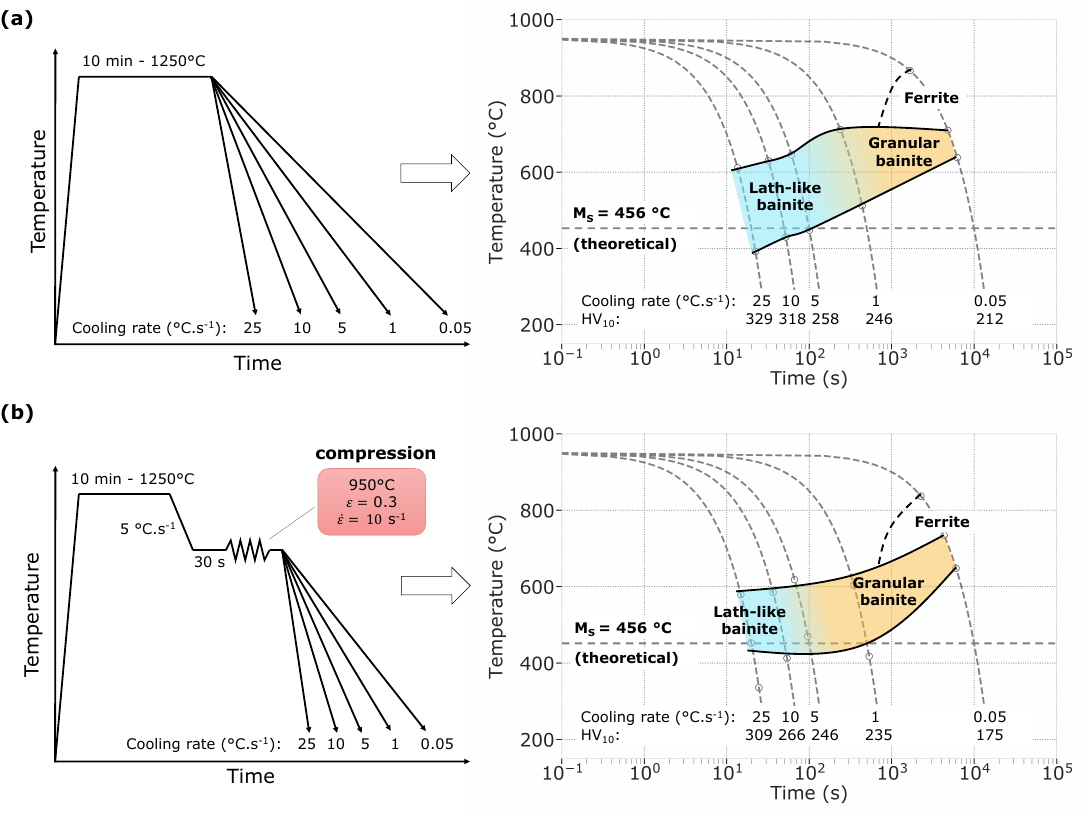
Figure 4. Thermal cycles applied and continuous cooling transformation diagrams with ( a ) undeformed austenite and ( b ) after austenite deformation at 950 ◦ C with ε = 0.3 and ˙ ε = 10s − 1